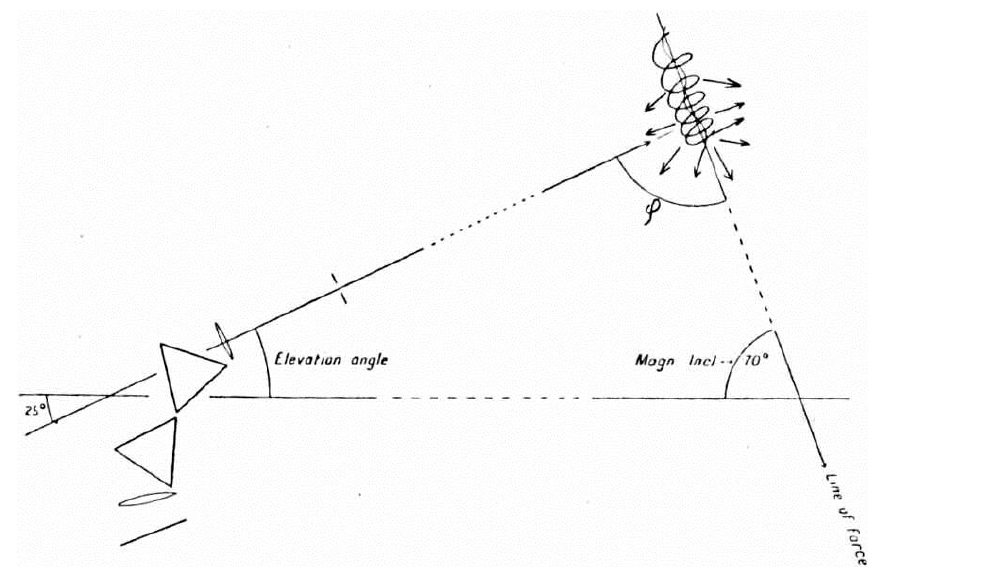
Figure 4. Schematic illustrating spectral results seen by two observers looking at the same H β emission source, parallel and perpendicular to the Earth’s magnetic field.